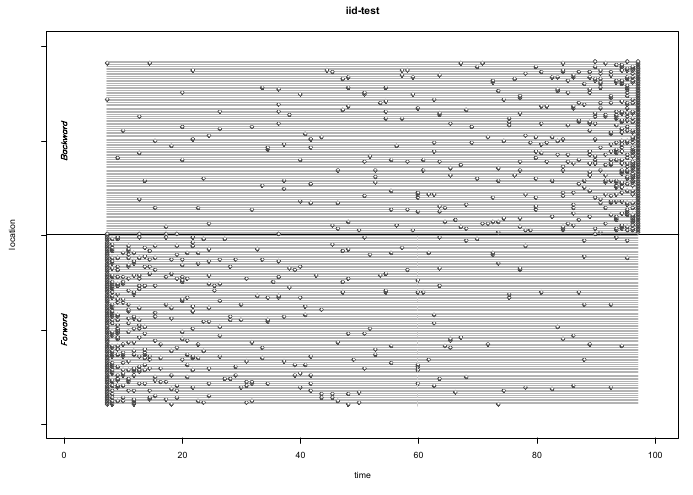
Figure 9 – Timing of the records